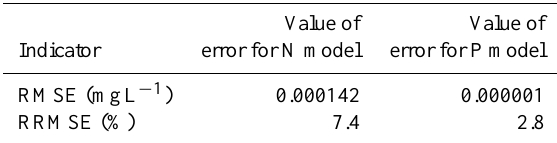
Table 5. Error magnitude considering only average